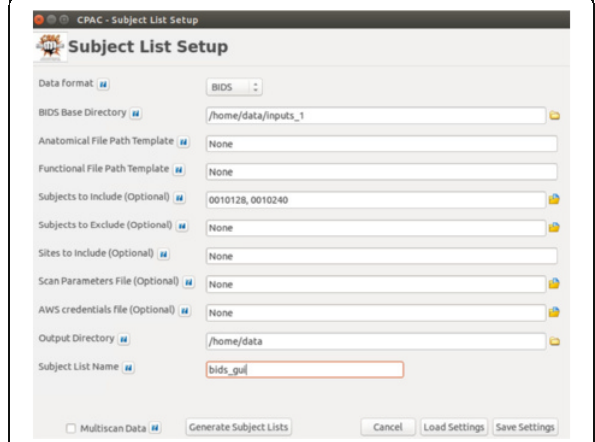
Fig. 2 (abstract A3). C-PAC subject list builder using BIDS